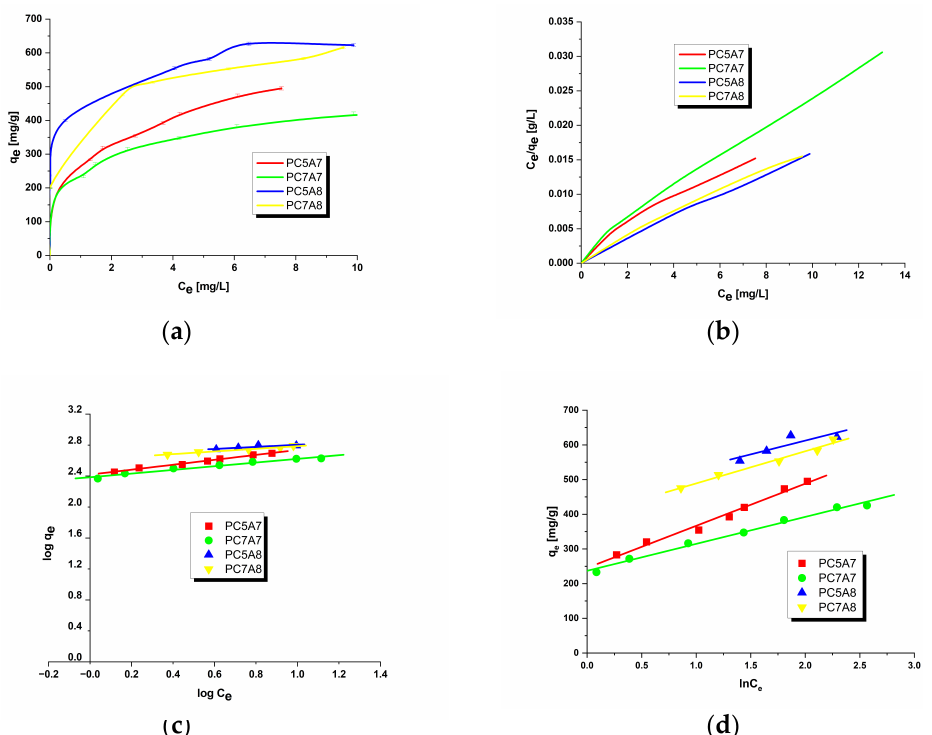
Figure 3. Adsorption of malachite green onto activated carbons ( a ) equilibrium adsorption of the dye, ( b ) Langmuir isotherm plots, ( c ) Freundlich isotherm plots and ( d ) Temkin isotherm plots.